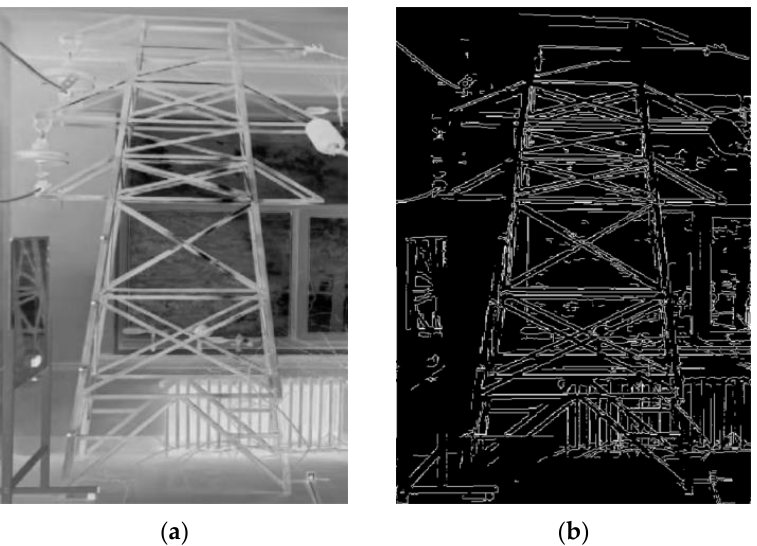
Figure 11. Monocular visual image preprocessing: ( a ) Grayscale of image; ( b ) Contour extraction and denoising.